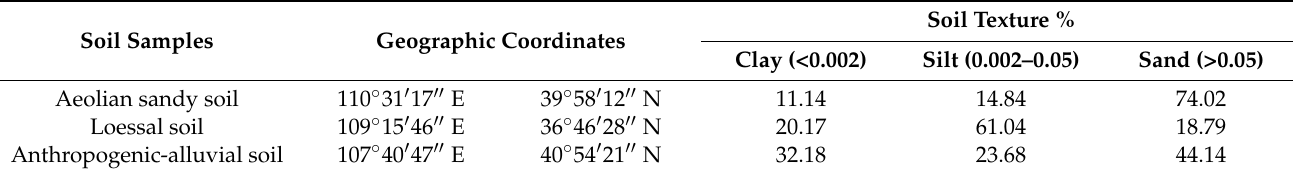
Table 1. Information on three soil